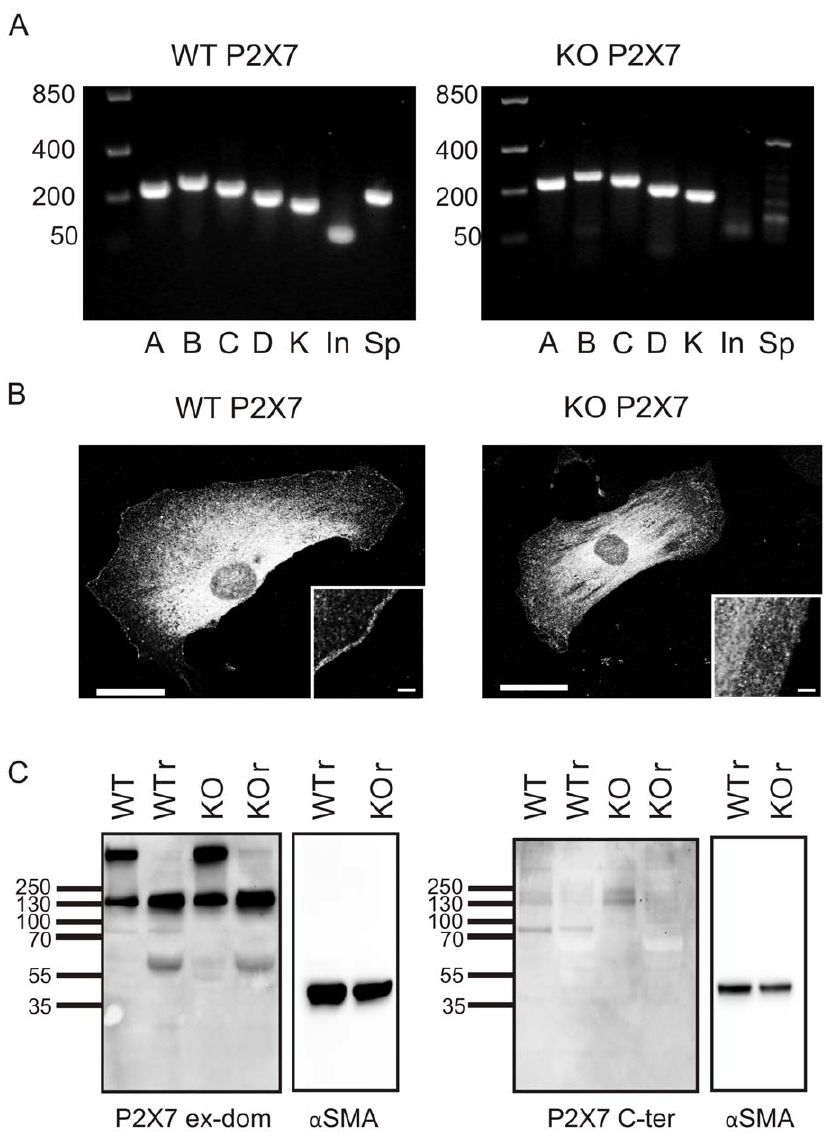
Figure 3. Expression of the P2X7 receptor in PSCs. A. PCR results from PSCs isolated from WT and KO mice illustrate the presence of all isoforms A–D and K; mRNA transcripts are also present in KO. The area disrupted by homologous recombination (In) is, however, absent. Similarly, the area spanning the disrupted area (Sp) is missing. B. Immunostaining of PSCs with primary antibody for the extracellular domain of the P2X7 receptor. Scale bar is 10 m M. C. Western blots on whole cell lysate with antibody against an extracellular domain (ex-dom) and the C-terminal part of P2X7 (C- term) in reducing (r) and non-reducing conditions. The loading control was a SMA and this blot was exposed for shorter times. Representative of 3 independent